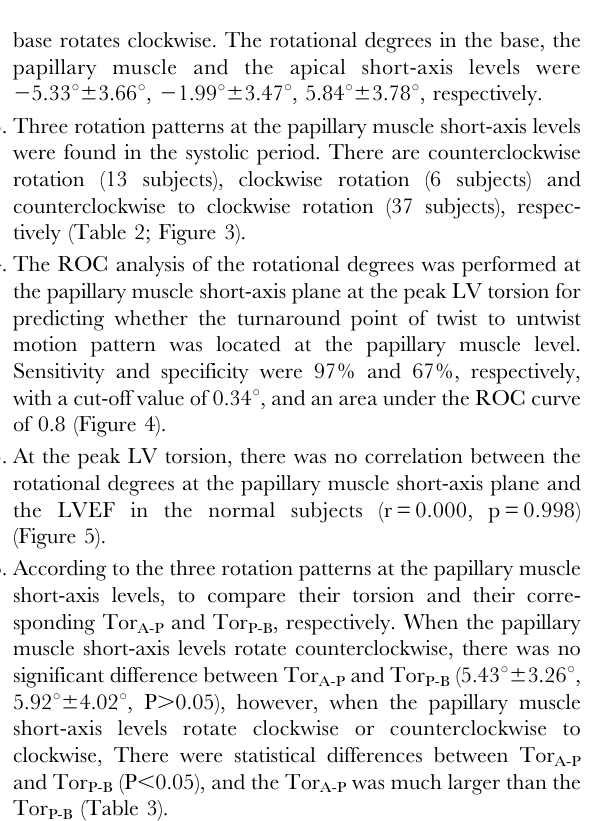
Variable Total ( u ) counterclockwise ( u ) clockwise ( u ) Counterclockwise- clockwise ( u )